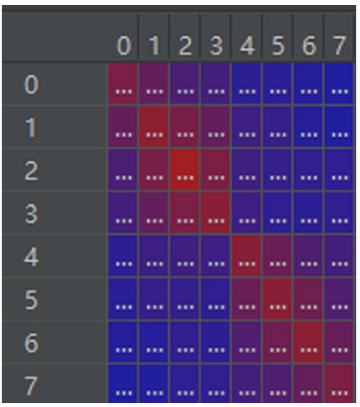
Fig. 4 H T M H M in multi-antenna user equipment (MAUE) with ξ r = 0, ξ t = 0.4, m UE =